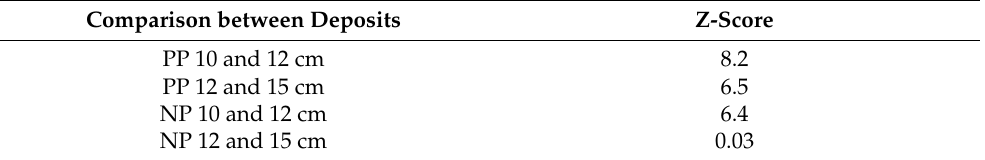
Figure 10. The 10,000x magnification of electrospun fibers from deposit 3. Table 5. Comparison between average fiber diameters at adjacent spinning